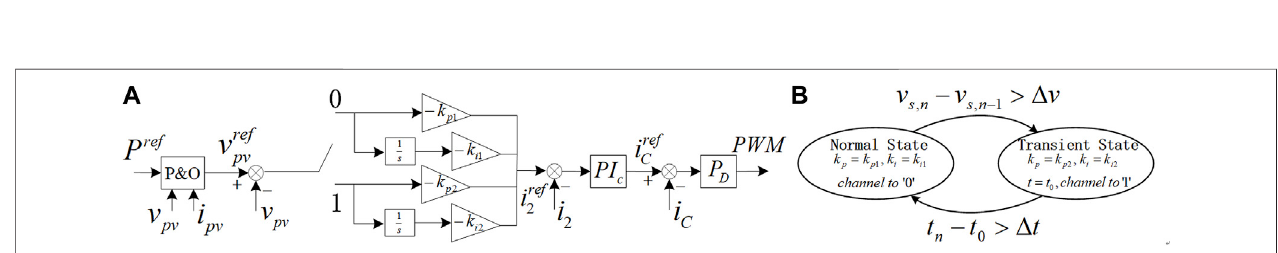
FIGURE7| P pv – v pv curveand P o – v pv curveduringthevoltagerecoverystage. (A) k i (cid:1) 5, C pv (cid:1) 1mF,and k p (cid:1) 0 . 1,0.2,0.4,and0.6. (B) k p (cid:1) 0 . 1, C pv (cid:1) 1mF,and k i (cid:1) 1, 10, 20, and 40. (C) k p (cid:1) 0 . 1, k i (cid:1) 5 and C pv (cid:1) 1mF, 5mF, 10mF, and 20mF.